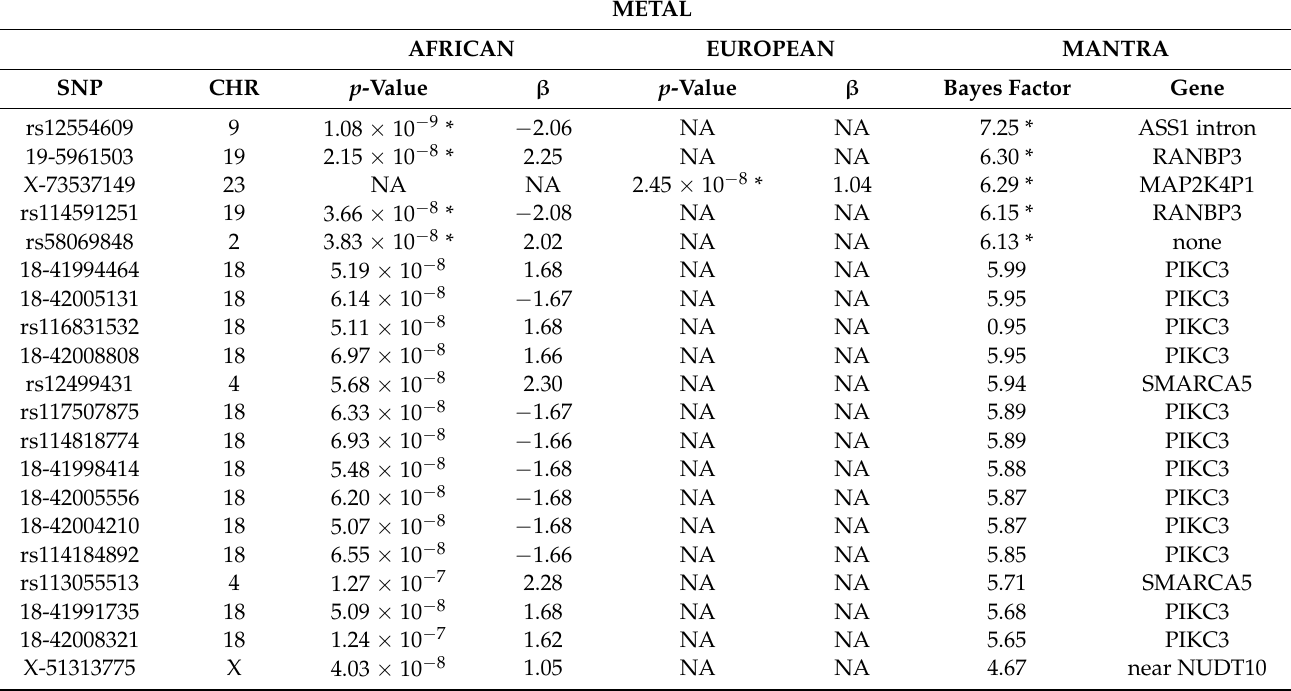
Table 3. METAL and MANTRA analyses for focal